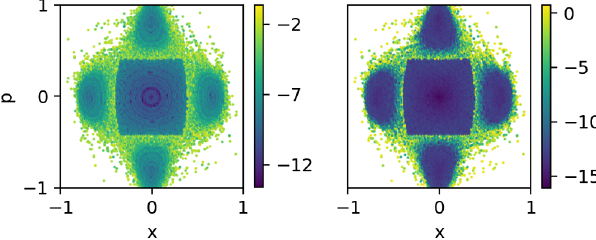
29. Dynamic aperture plot with a thin octupole near the quarter-integer resonance using FMA(left) and REM(right) with the time interval T ¼ 256